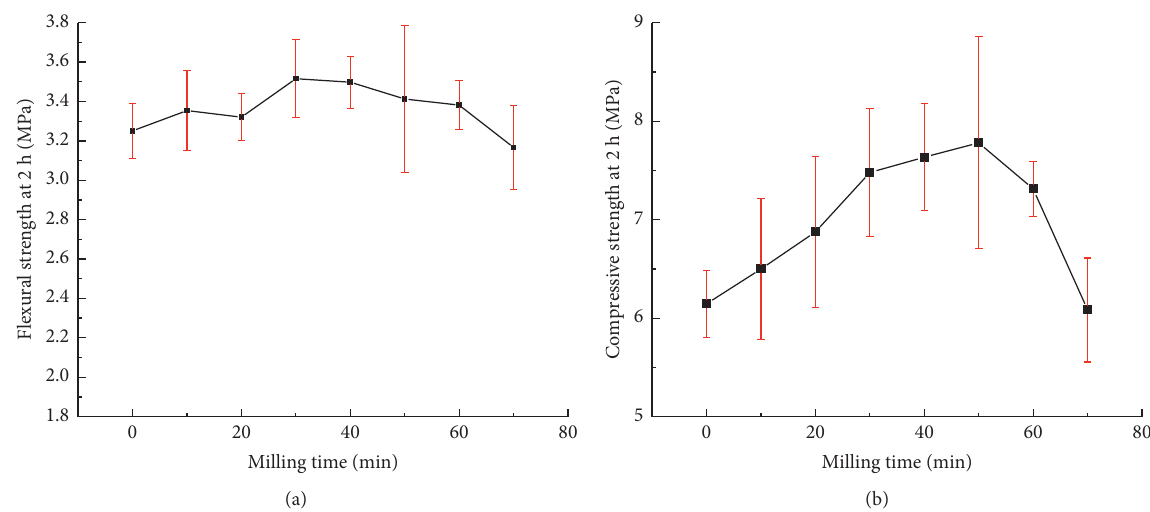
Figure 7: Variation of the strength of PBG at 2h. (a) Flexural strength. (b) Compressive